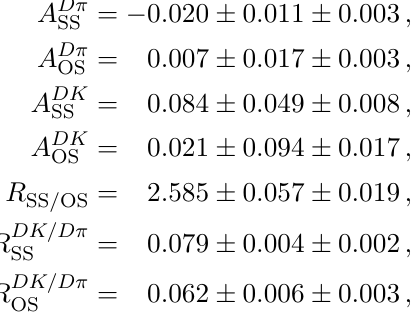
Figure 5 . Invariant mass of OS B (cid:6) components are detailed in the legend of (cid:12)gure